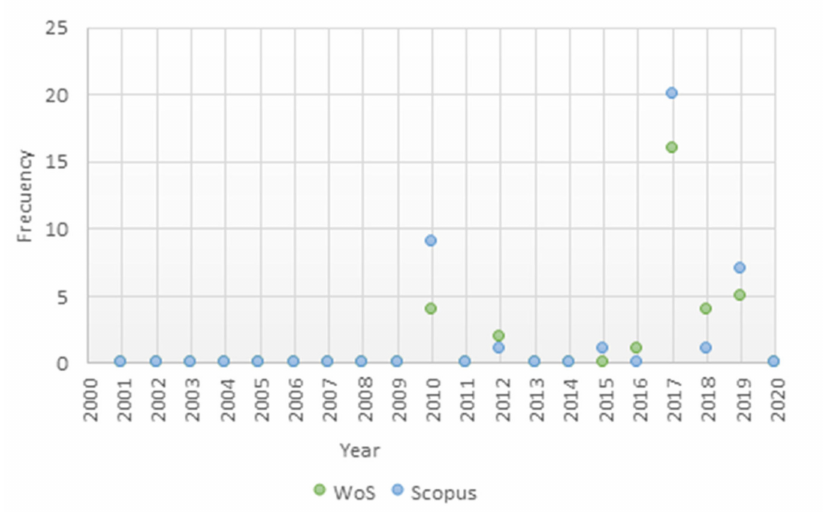
Figure 6. Evolution of citations in WoS and Scopus in articles on “Magic Towns”. Source: Own